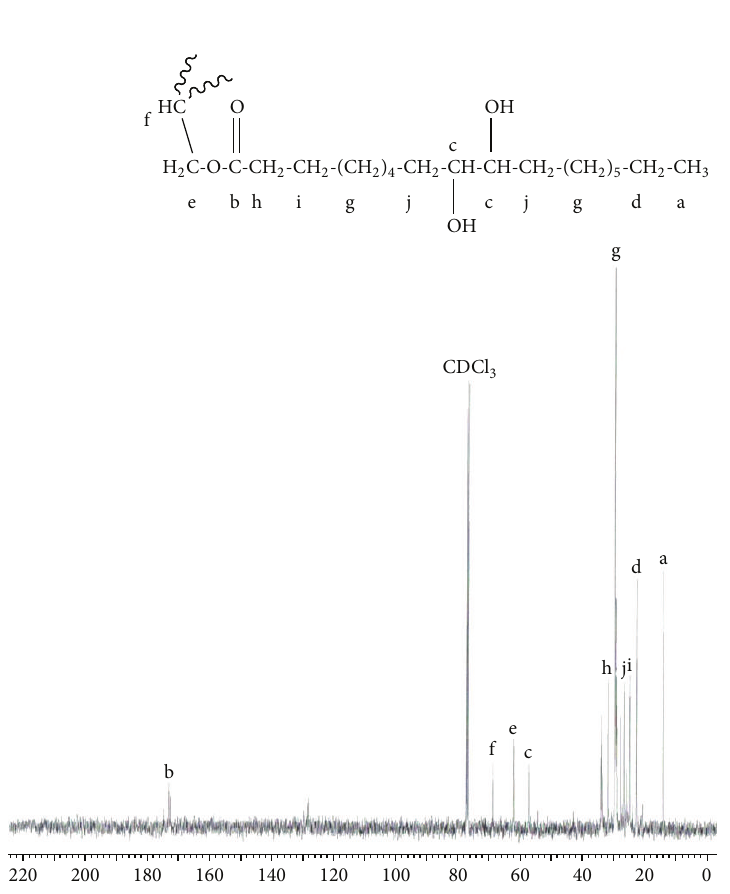
Figure 5: 13 C-NMR spectra of